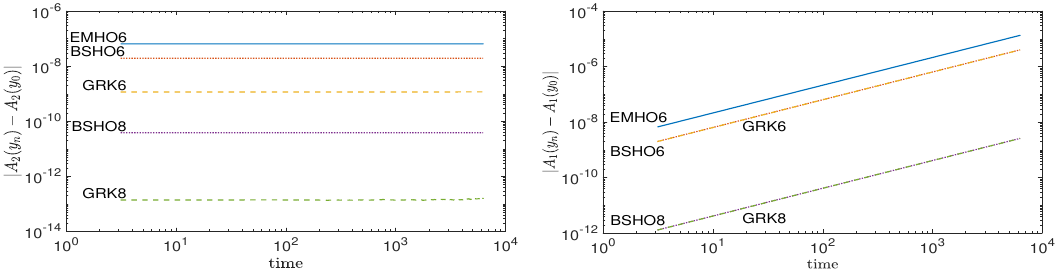
Figure 1. Kepler problem: results for the sixth (BSHO6, red dotted line) and eighth (BSHO8, purple dotted line) order BSHO methods, sixth order Euler–Maclaurin method (EMHO6, blue solid line) and sixth (Gauss–Runge–Kutta (GRK6), yellow dashed line) and eighth (GRK8-green dashed line) order Gauss methods. ( Left ) error in the second component of the Lenz vector; ( Right ) error in the first component of the Lenz vector.